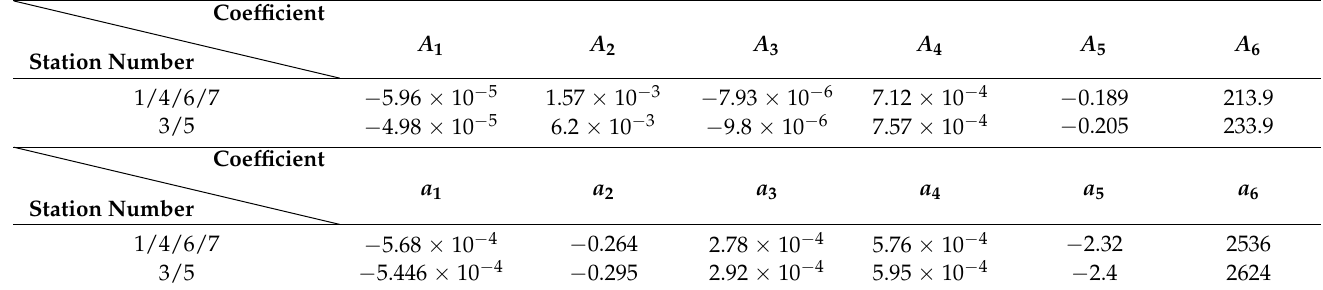
Table 2. The fitting results.